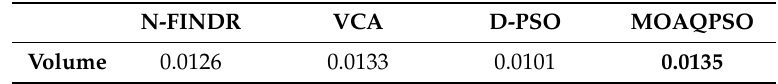
Table 2. Comparison between the simplex volumes obtained by N-FINDR, VCA, D-PSO, and MOAQPSO. N-FINDR VCA D-PSO